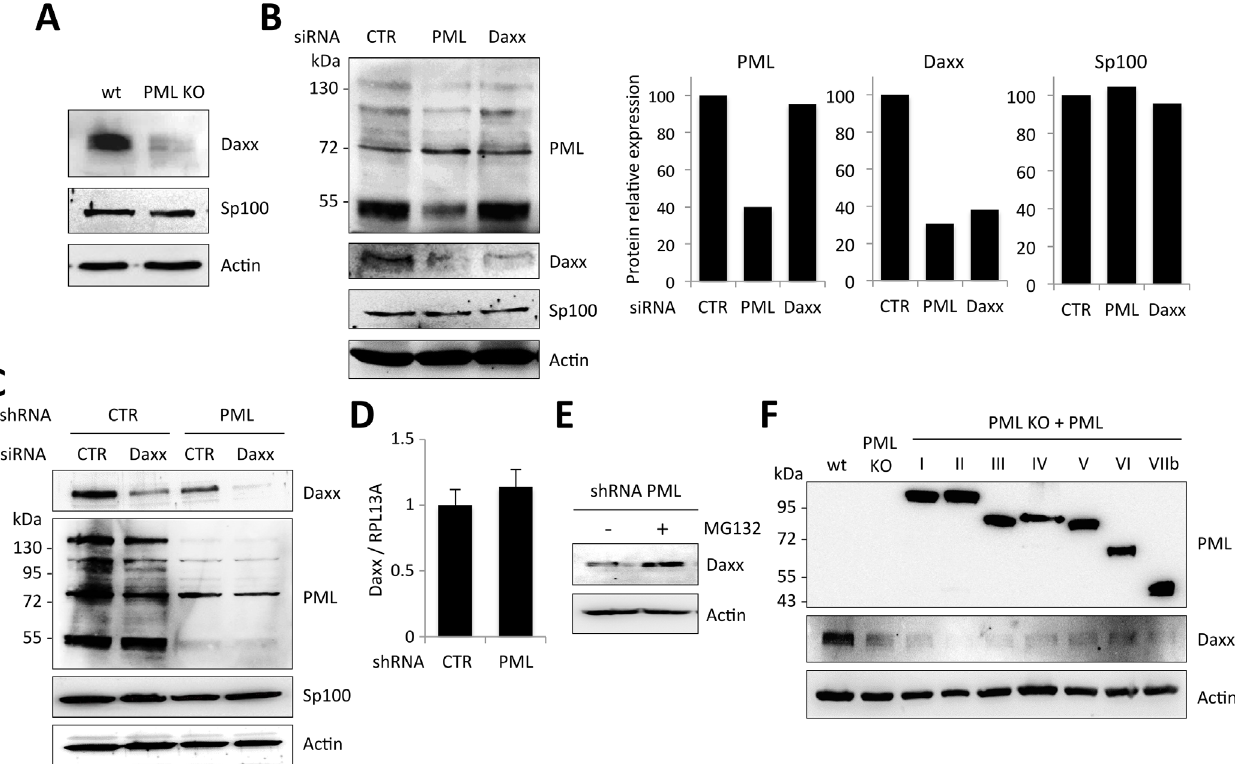
Fig 8. PML expression is required for Daxx stability. (A) Western-blot analysis of Daxx, Sp100 and actin expression in wt and PML KO MEFs. (B) Western-blot analysis of PML, Daxx, Sp100 and actin expression in wt HeLa cells transfected with non-targeting control (CTR), PML-specific or Daxx-specific siRNA. Intensity of individual bands was quantified using ImageJ software. (C) HeLa cells stably expressing a non-targeting control shRNA (CTR) or a PML- targeting shRNA were transfected with CTR or Daxx-specific siRNA. Expression of Daxx, PML, Sp100 and actin were evaluated by western-blot analysis. (D) Daxx mRNA relative expression in HeLa cells expressing CTR or PML-targeting shRNA, expressed as a ratio to RPL13A mRNA expression. (E) HeLa cell expressing PML-targeting shRNA were treated with MG132 for 6 h and analyzed by western-blot for Daxx and actin expression. (F) Western-blot analysis of PML, Daxx and actin expression in wt, PML KO and PML KO MEFs stably expressing each human PML isoform (PMLI to PMLVIIb). Note that endogenous PML was not detected in wt MEFs because the western-blot was revealed with anti-PML antibodies specific to human PML isoforms.